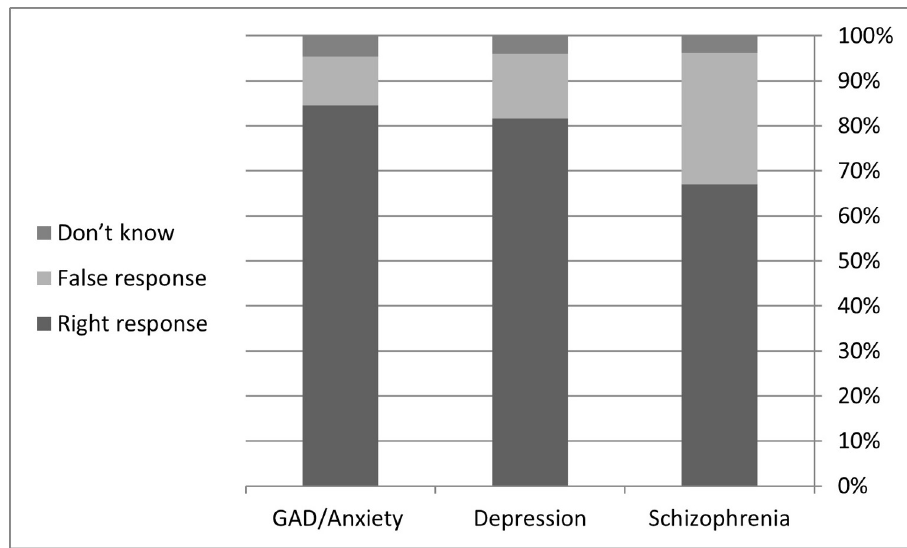
Fig 2. Supporting information: (Knowledge towards the three mental disorders) [depression].